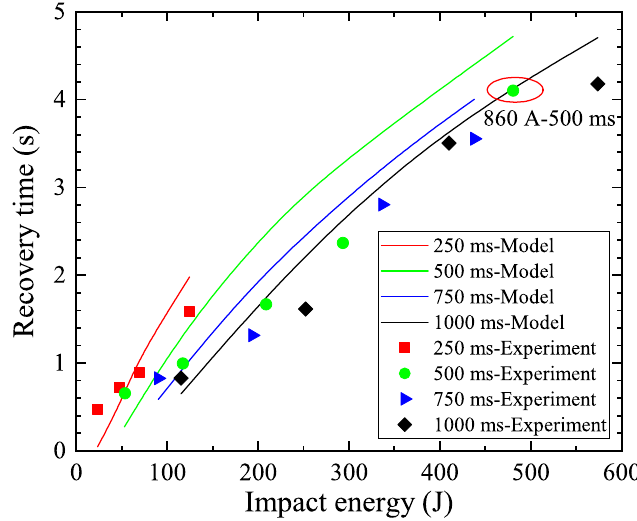
Figure 10. Calculated recovery time compared with experimental results. Lines and dotted lines represent calculated and experimental results, respectively. The recovery time is calculated from the measured peak resistance during the recovery process. The recovery time of a supplementary experiment in the red circle will be discussed